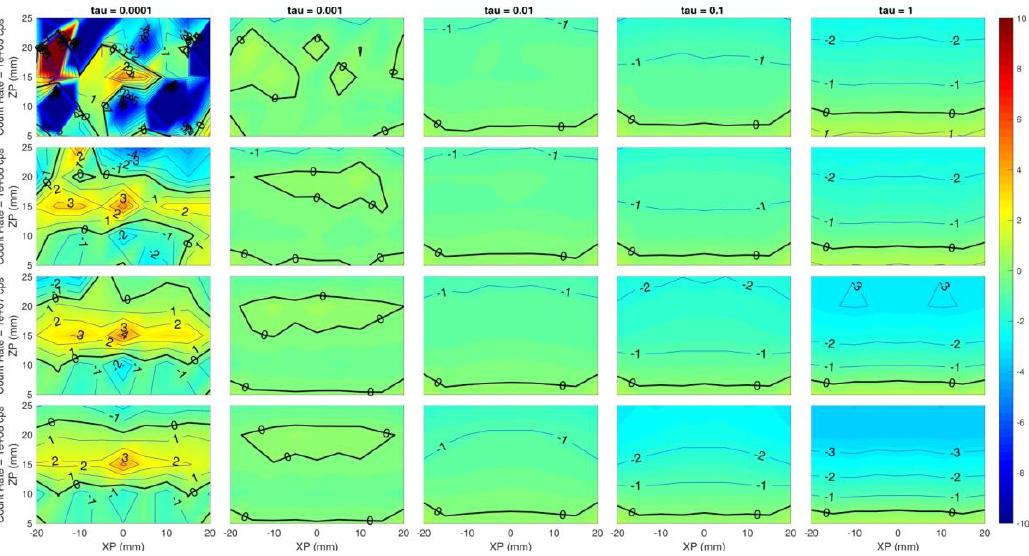
Figure 4. Localization error on the z coordinate for different count rates (rows) and 𝜏 (columns). Horizontal axis of each subplot is the simulated x position of the inclusion and vertical axis is the simulated z position. Colors show an error of − 10 mm (blue) to +10 mm (red).